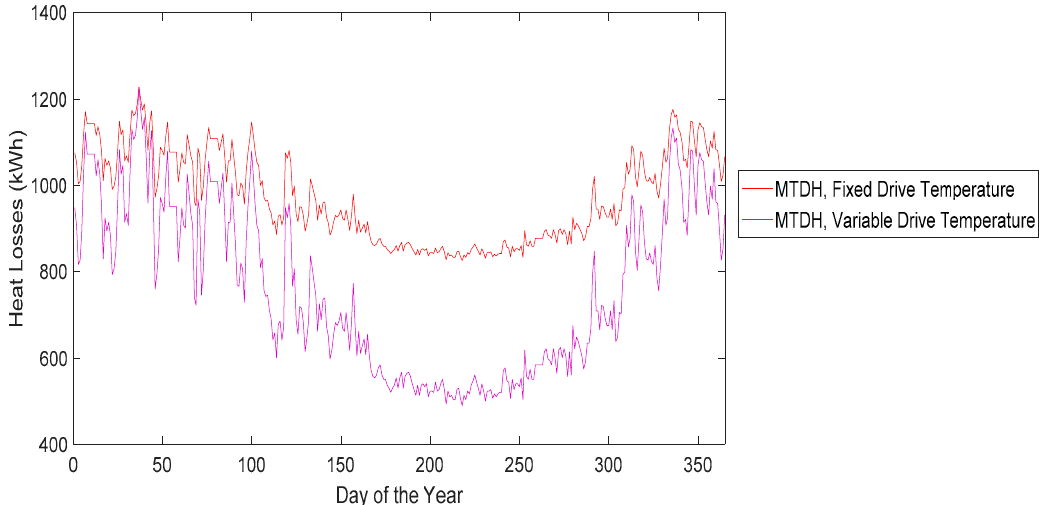
Figure 9. Comparison of losses in a medium temperature network along the year with fixed and variable network temperatures.